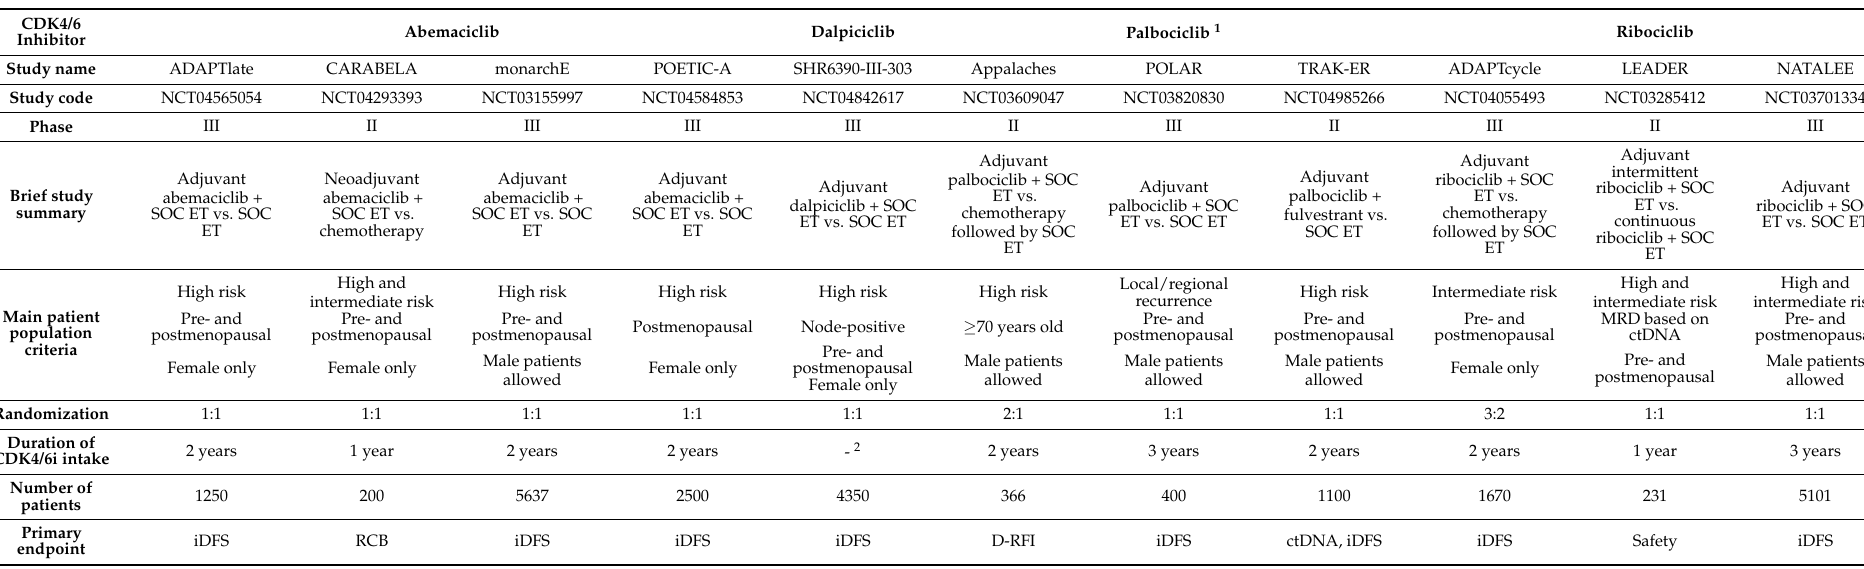
Table 3. Selection of key ongoing CDK4/6 inhibitor trials on hormone-receptor-positive, HER2-negative eBC (in alphabetical order; based on clinicaltrials.gov, accessed on 22 September 2021)